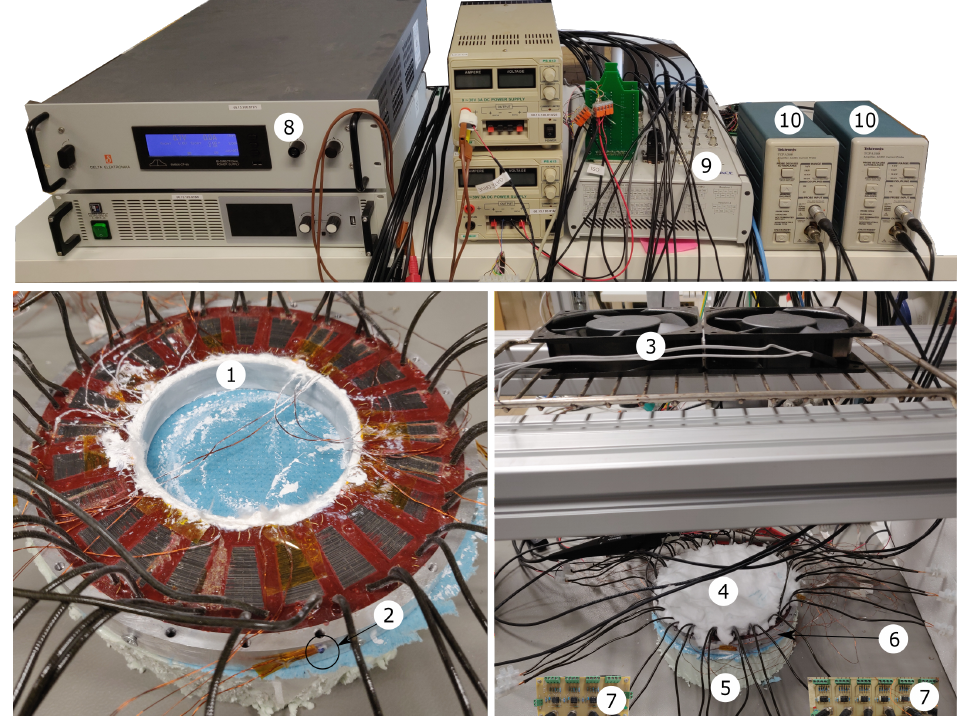
Figure 5. Experimental test setup. (left) Detailed view of prototype stator (1) thermal end-winding interconnection (2) PT100 temperature sensor on aluminium housing (right) Overview of setup: (3) cooling fans (4) thermal insulation wool (5) Expanded Polystyrene Insulation (XPS) (6) prototype stator between insulation (7) PT100 temperature sensor signal conditioning board (8) DC power sup- ply (9) dSPACE MicroLabBox ® real time control and data processing unit (10) Tektronix ® TCPA 300 current